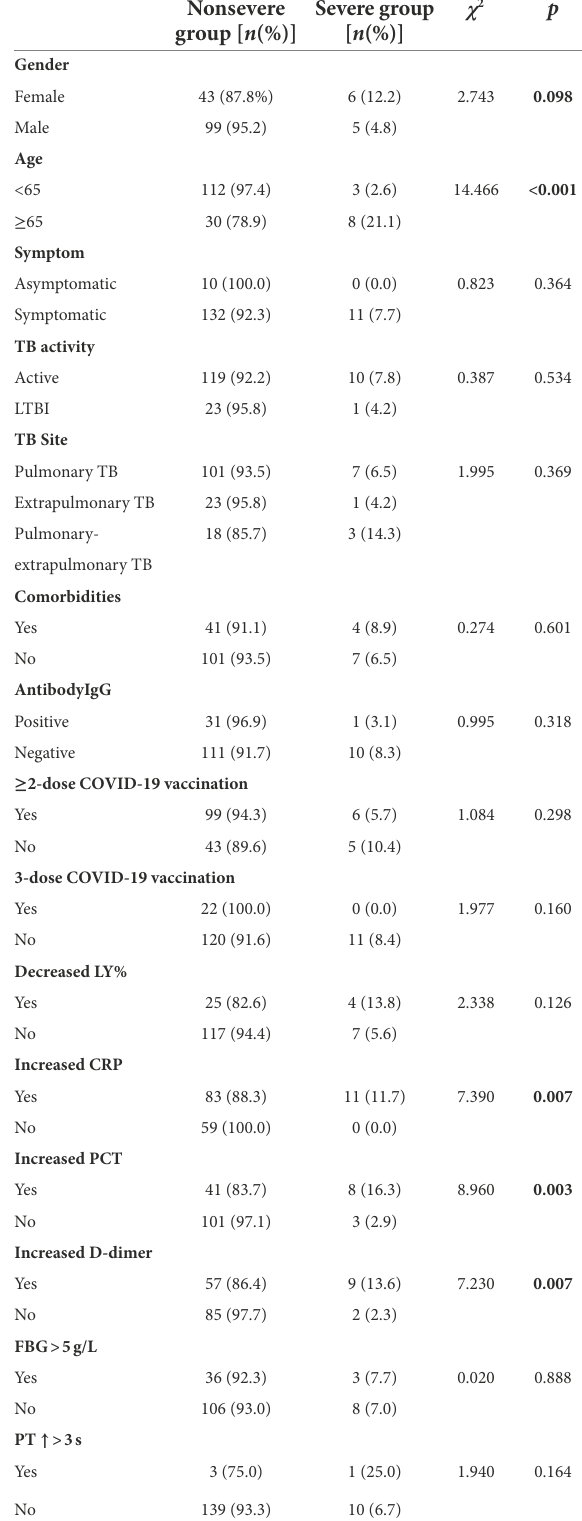
TABLE 2 The routine laboratory data of 153 coinfection patients [median (interquartile range)]. Variables